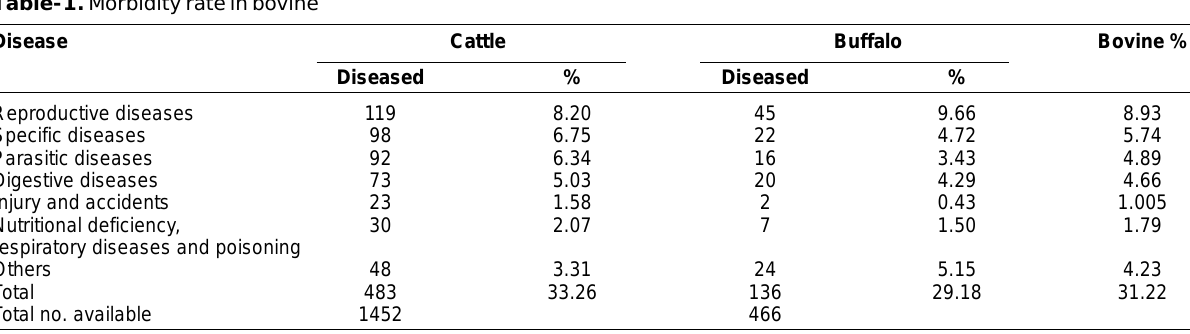
Table-1.1. Age wise morbidity rate in bovine